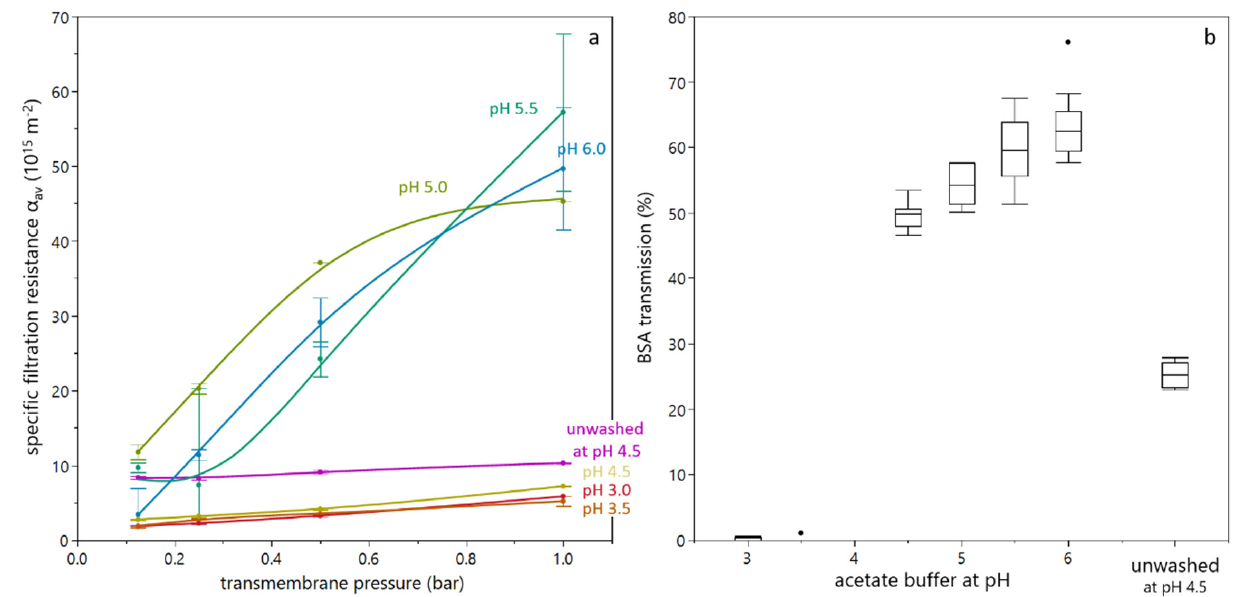
Figure 6. Dead-end filtration of a yeast-BSA mixture with 10% dry matter content: The specific filtration resistance as a function of transmembrane pressure, where error bars indicate the range of a duplicate ( a ) and the transmission of BSA for different buffers, where values from duplicate measurements at different transmembrane pressure were considered ( b ). The BSA transmission did not significantly change with transmembrane pressure in the investigated transmembrane pressure range.